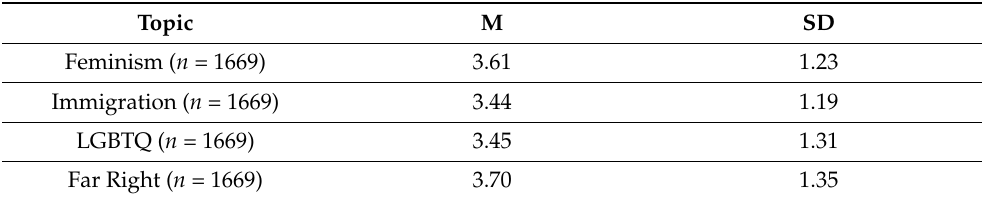
Table 5. Interest in the different news